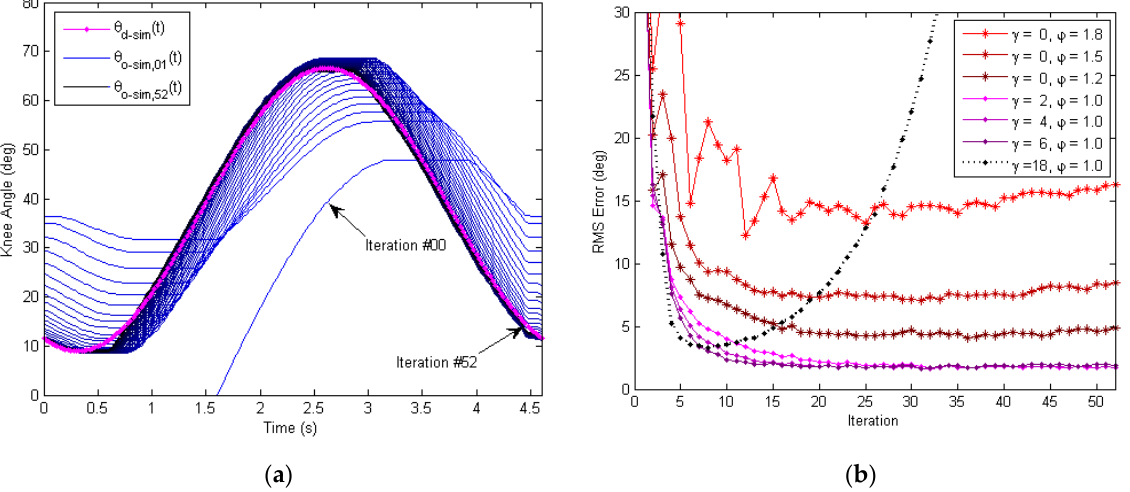
Figure 11. Time-domain simulation of the outer-loop learning-based repetitive controller. A P-type learning law with the phase-lead compensation is used. ( a ) Convergence history for the exoskeleton knee joint angle in time domain, with all iterations overlapped. Here, the phase-lead compensation is γ = 5, and the learning gain is ϕ = 0.2. ( b ) Convergence plot of RMS tracking error in iteration domain. The outer learning loop is unstable for γ = 0 and higher γ values (within a range) help improve the convergence.